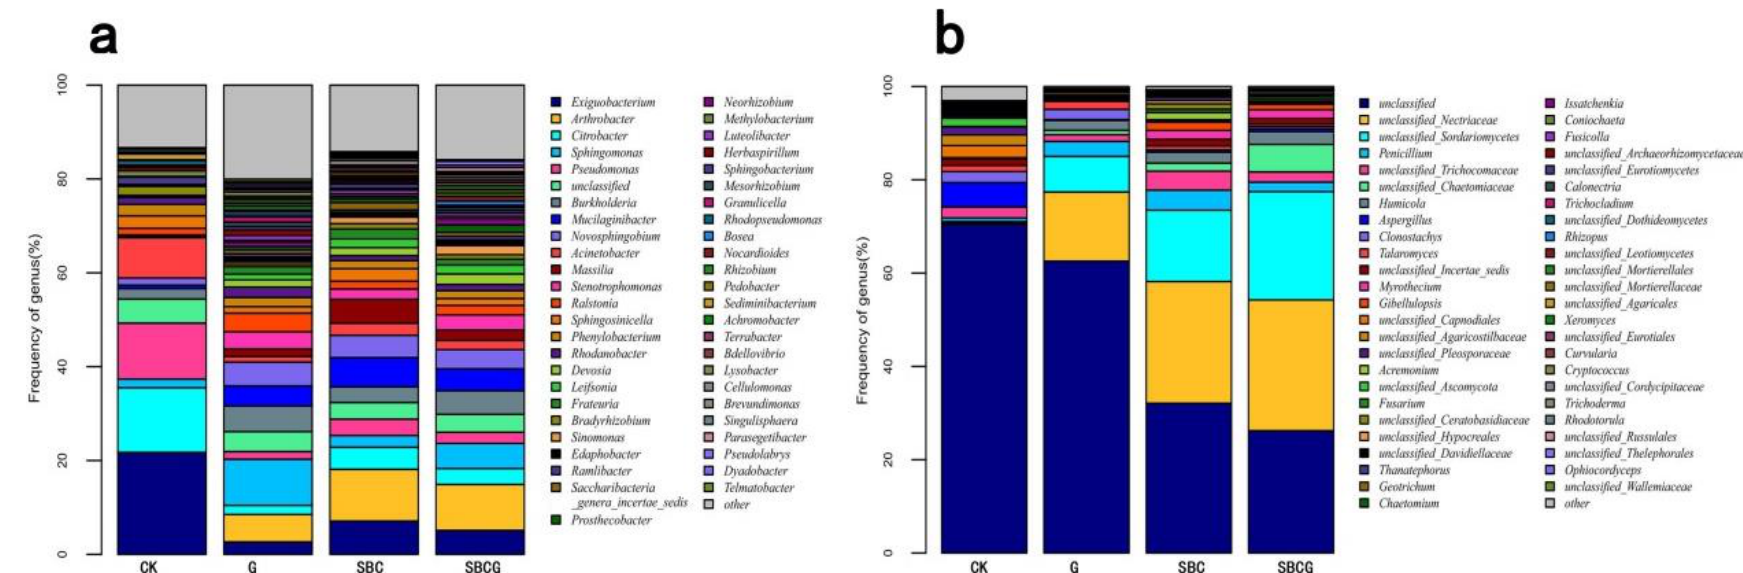
Figure 4. Frequency of bacterial ( a ) and fungal ( b ) genera detected in IAC mining wasteland soil in the un-amended control (CK), alfalfa revegetation (G), sludge biochar amendment (SBC), and combined amendment (SBCG) treatments. Abundance is presented in terms of the average percentage, classified by RDP classifier at a confidence threshold of 80%. “Other” refers to the sum of unclassified sequences and all other taxa with abundances < 0.9% in any sample.